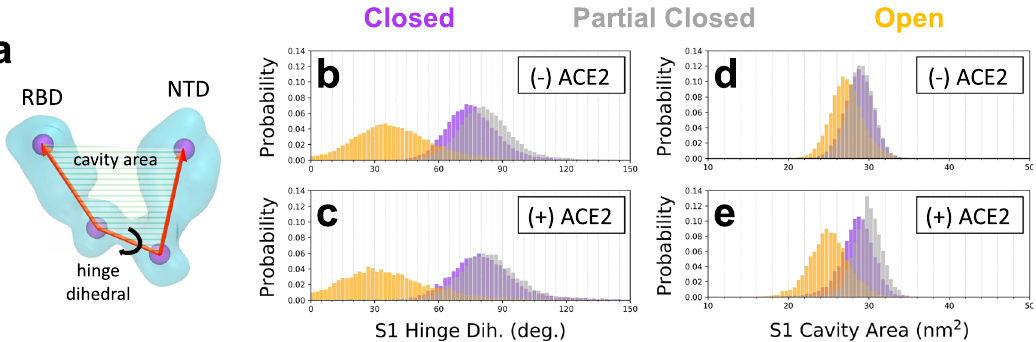
Fig. 3 Structural changes to S1 upon ACE2 binding. a Schematic of the four geometric points (purple spheres) in S1 used to de fi ne the hinge dihedral and the cavity area. b , c Probability distributions of the hinge dihedral in each of the three structural states (closed, partially closed, and open) in the absence ( N = 75003) and presence ( N = 43800) of ACE2. d , e Probability distributions of the cavity area in each of the three structural states (closed, partially closed, and open) in the absence ( N = 75003) and presence ( N = 43800) of